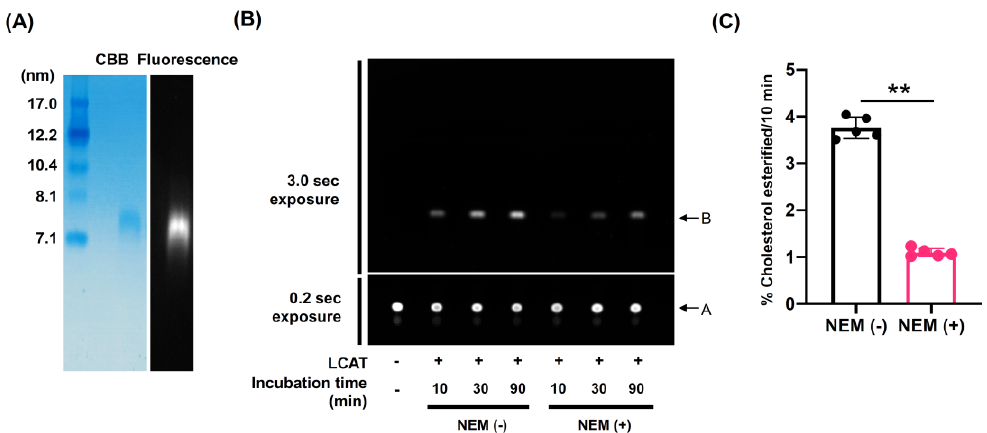
Figure 4. Development of a fluorescence-based assay for LCAT activity. ( A ) rHDL containing both BODIPY-cholesterol and POPC was prepared and native PAGE analysis was performed in a 4 – 20% polyacrylamide gel. Standard proteins of known hydrodynamic diameters were used for the analysis. Samples (1.0 μ g proteins) were separated by non-denaturing gel electrophoresis and stained with Coomassie Brilliant Blue (left). The same Native PAGE gel was analyzed with a ChemiDoc Touch MP (Bio-Rad) set at 488 nm for excitation and 520 nm for emission (right). ( B ) rhLCAT or rhLCAT pre-incubated with NEM was incubated with rHDL containing BODIPY-cholesterol and POPC for 10 – 90 min at 37 °C. The extracted lipids were dissolved in 30 μ L of chloroform and applied to the TLC plate. The TLC plate was placed into a closed glass tank, saturated by a developing solvent (petroleum ether, diethyl ether, and acetic acid in mole portions of 230:60:3). After 25 min, the plate was removed and the cholesterol spots (Position A) and esterified cholesterol spots (Po- sition B) were detected using a ChemiDoc Touch MP set at 488 nm for excitation and 520 nm for emission. In order to visualize spots clearly, cholesterol spots were exposed for 0.2 sec and esterified cholesterol spots were exposed for 3.0 sec. ( C ) The TLC plate was exposed for 0.2 sec and cholesterol spots and esterified cholesterol spots were quantified by densi- tometry analysis using ImageJ ® software. Cholesterol esterification rate was calculated as the percentage of cholesterol esterified during HDL incubation at 37 °C in 10 min. Values are expressed as the mean ± SD ( n = 5). ** p < 0.01. Data analyzed by unpaired Mann – Whitney test.